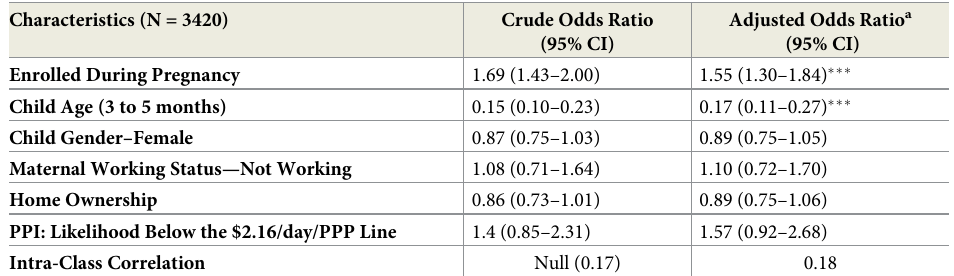
Table 4. Association between infant enrolled during pregnancy and exclusive breastfeeding for participants in a community-based child nutrition program in informal settlements of Mumbai, India. Characteristics (N = 3420)